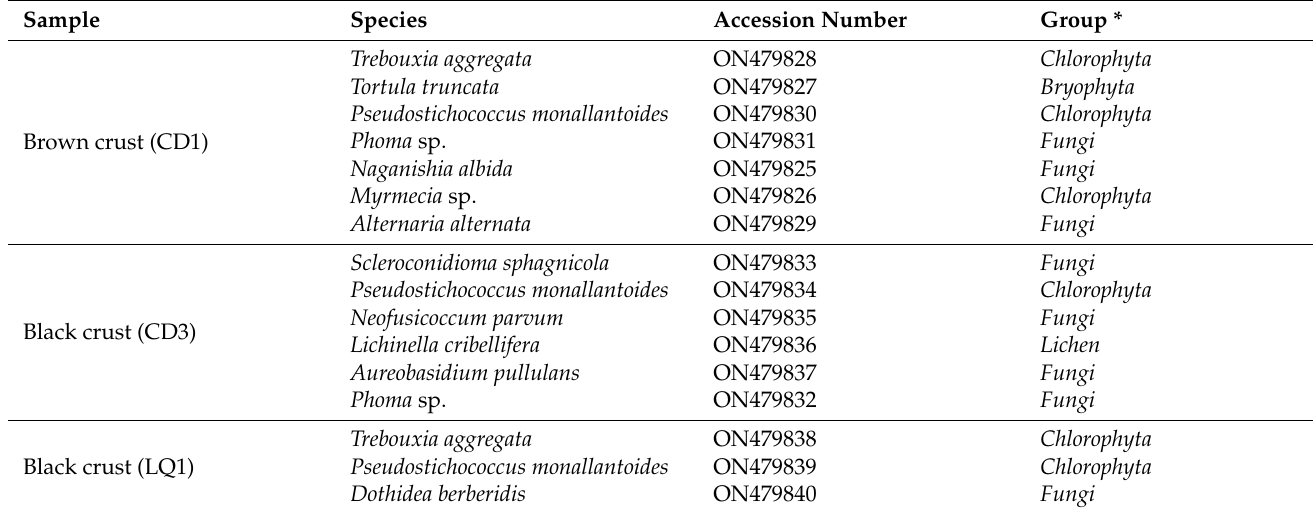
Table 1. Description of samples from the Cross of the Inquisition, Seville City Council, and list of eukaryotic